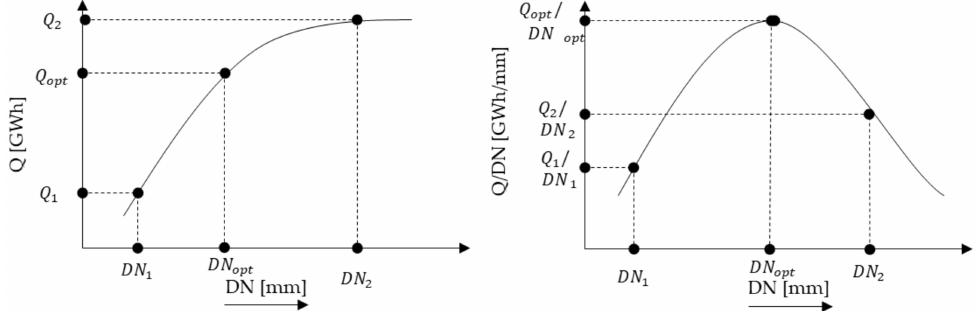
Figure 10. ( Left ) Utilized heat to the DH network in relation to the connection pipe diameter; ( right ) optimal DH network connection pipe